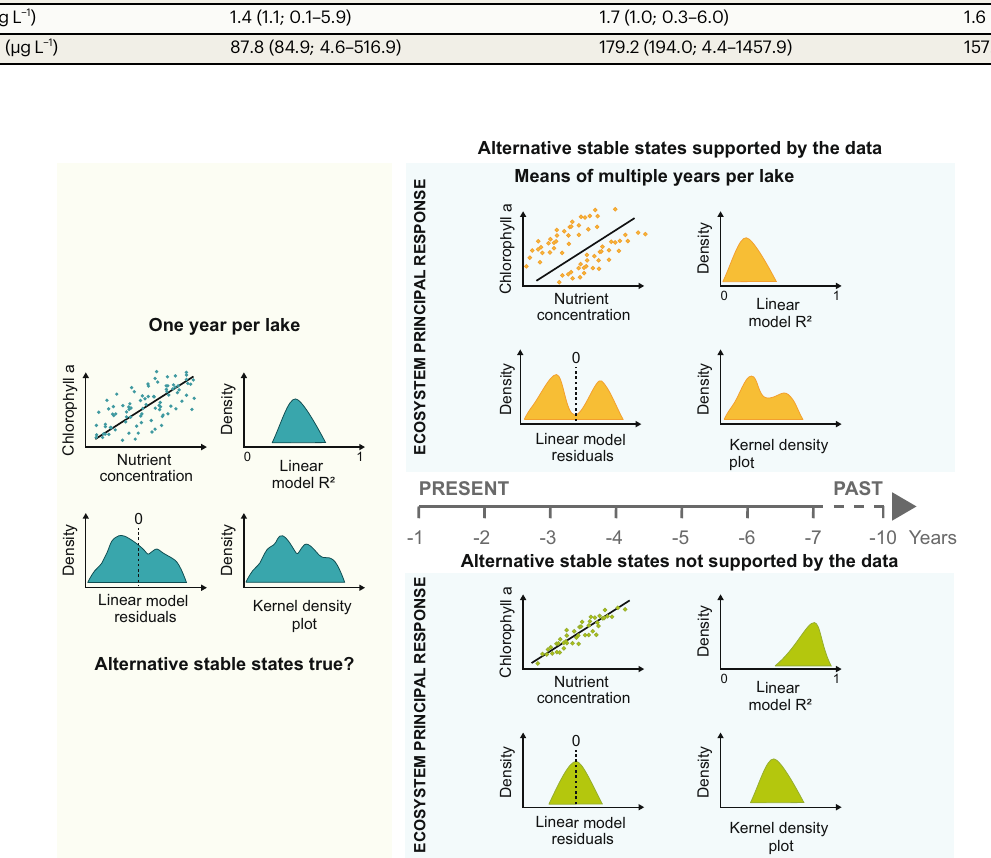
means the expectation is that inter-annual variability should even out and the presence or absence of ASS should become apparent in the proxies (above the horizontalline).Thescatterplotofchlorophyll-aversusthenutrientswillshowtwo clouds of data (turbid or clear), hence, (i) the R ² of the model will decrease, as a single linear model cannot predict two alternatives, (ii) the residuals of a linear model correlating nutrients to chlorophyll-a will show multimodality and (iii) the kernel density plot of chlorophyll-a will deviate from unimodality. Conversely, in the absence of ASS (below the horizontal line), the link between nutrient con- centration and chlorophyll-a becomes increasingly well predicted by a linear model, resulting in a larger R ² with an increasing number of averaged year, unim- odality of the model residuals and of the kernel density